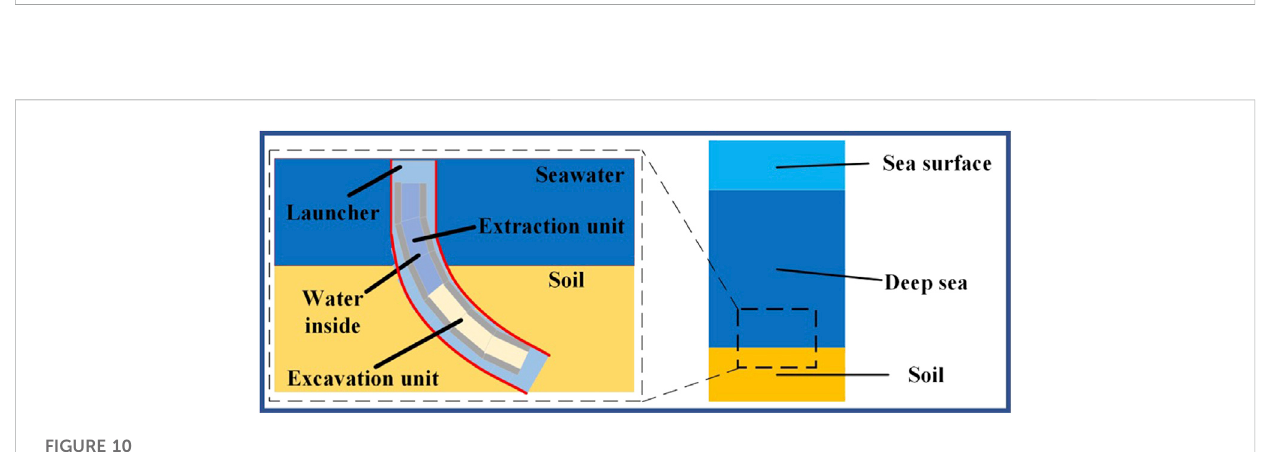
FIGURE 10 Model of robot operation in sea fl